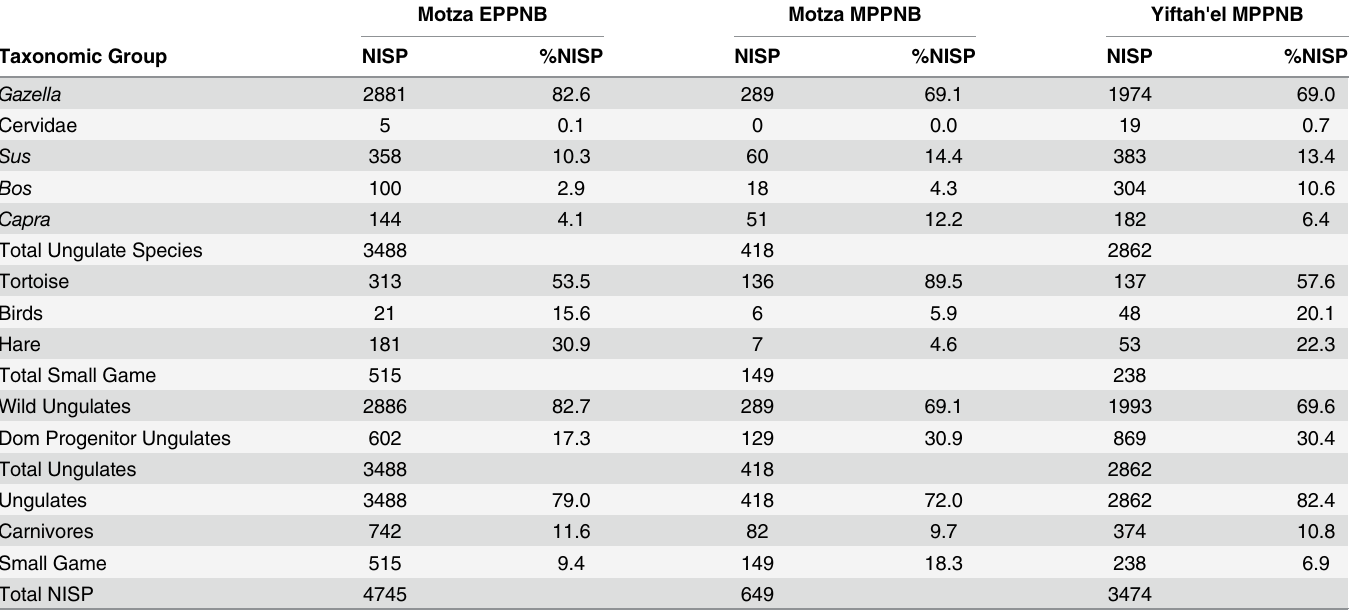
Table 2. NISP totals for taxonomic groupings used in relative taxonomic abundance analyses.